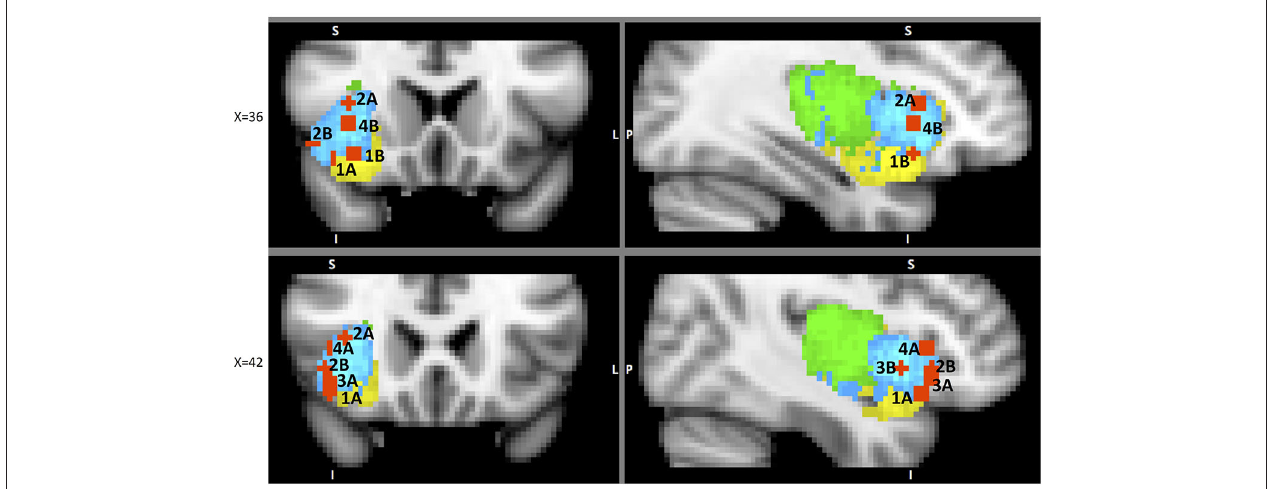
FIGURE 5 | A sample of studies addressing the IC’s role in Outcome Processing Phase (for illustration purposes only). Sub-regions of the Insula: posterior (green), dorsal anterior (blue) and ventral anterior (yellow). IC activations in reaction to 1 – error awareness (A) in Klein et al. (2007) (41, 23, − 14) and (B) in Harsay et al. (2012) (34, 18, − 12); 2 – post error slowing in Li et al. (2008), (A) (36, 20, 8) and (B) (44, 24, − 4); 3 – non-reciprocated cooperation in Rilling et al. (2008a) (41, 25, − 8); 4 – harm prevention (A) in Kuhnen and Knutson (2005) (42, 23, 5) and (B) in Campbell-Meiklejohn et al. (2008) (36, 18,